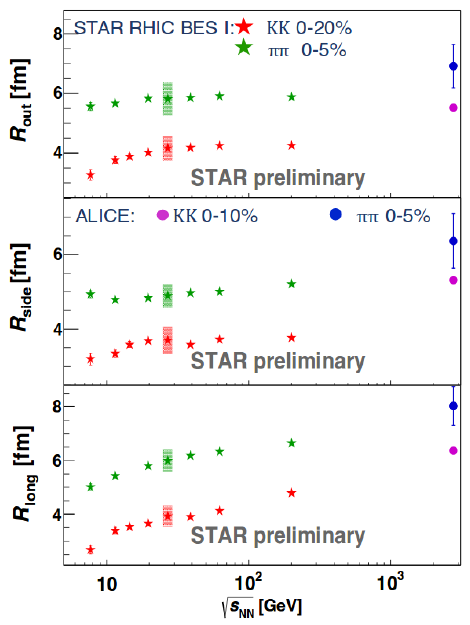
Figure 3. Collision energy dependence of R out , R side , R lon g for pions (green markers) and kaons (red markers). Stars and circles represent data obtained by the STAR and ALICE experiments,